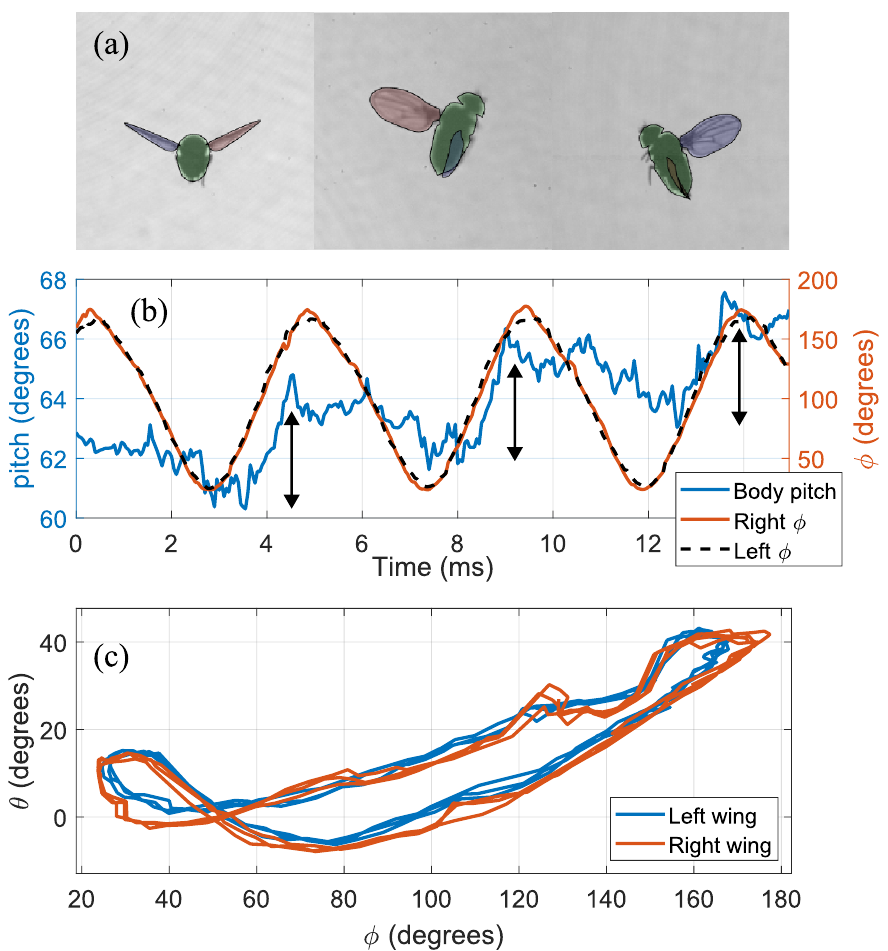
Figure 9. Results on an unperturbed flight event. ( a ) The projection of a fitted 3D model superimposed on the corresponding frames. ( b ) Body pitch and wing φ . Body pitch oscillations are marked in black vertical arrows. ( c ) The path of the wing tip by its elevation ( θ ) and azimuth ( φ